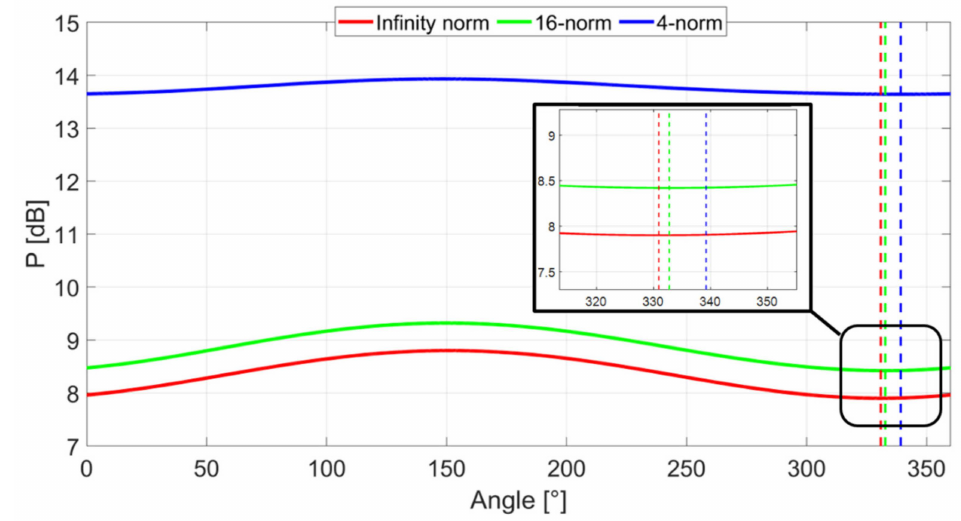
Figure 3. Continuous lines: Approximated PAPR P with norm n = 4 (blue), norm n = 16 (green) and norm n = ∞ (red) when changing only one phase angle from 0 ◦ to 360 ◦ . Vertical dashed lines show (with the same color) the minimum of the three curves. A zoom of the minimum points is reported in the